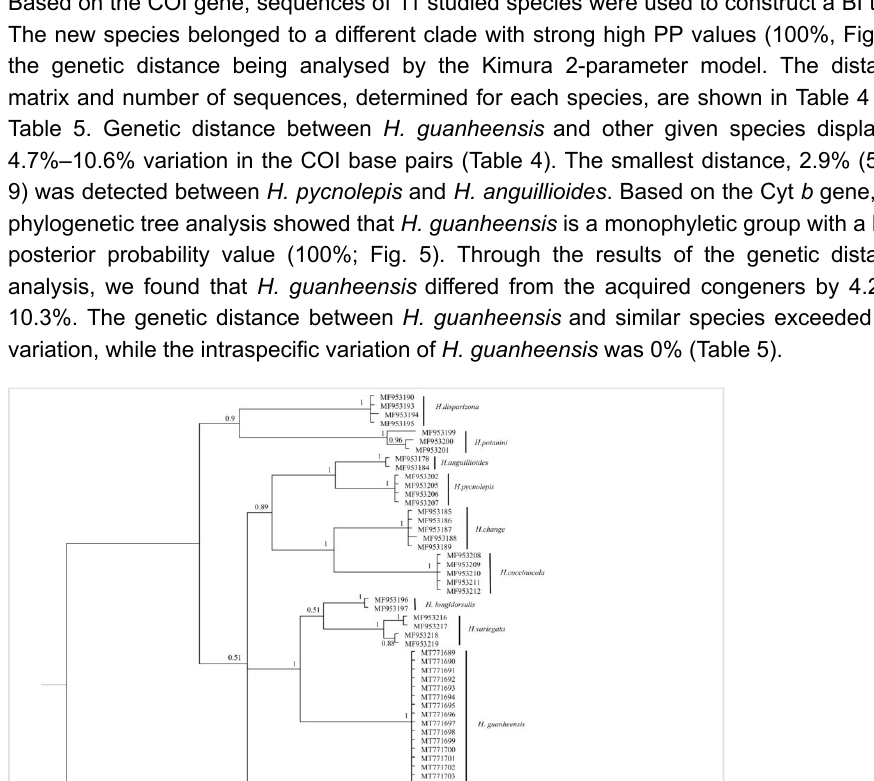
Based on the COI gene, sequences of 11 studied species were used to construct a BI tree.